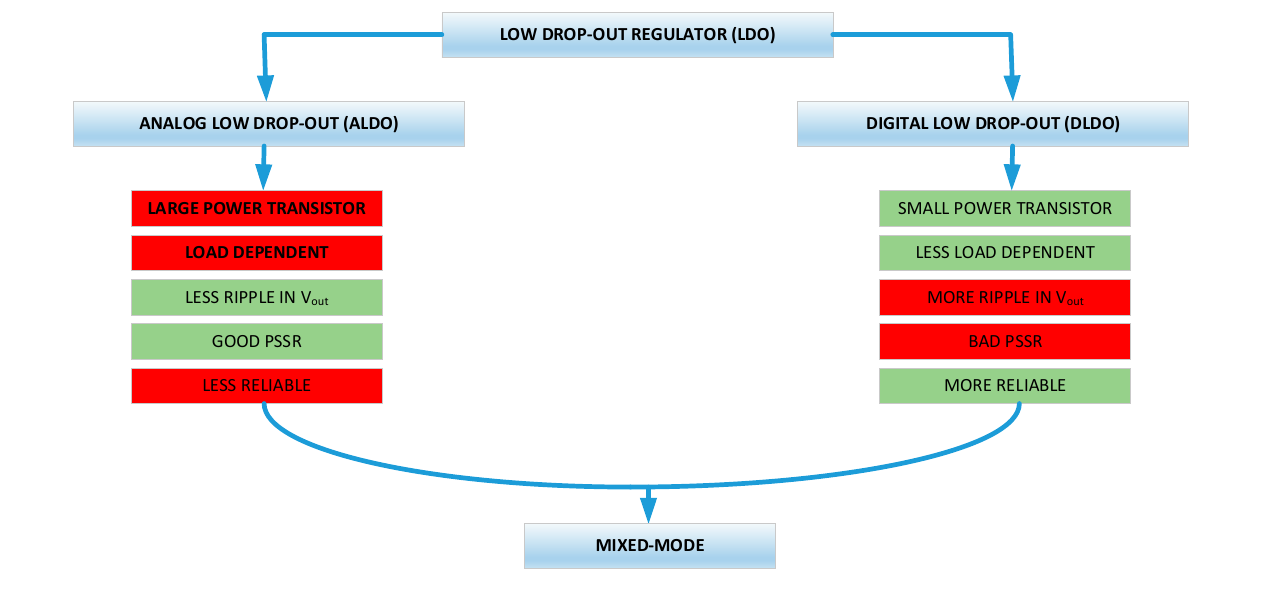
Figure 6. Characteristics of different types of LDOs.